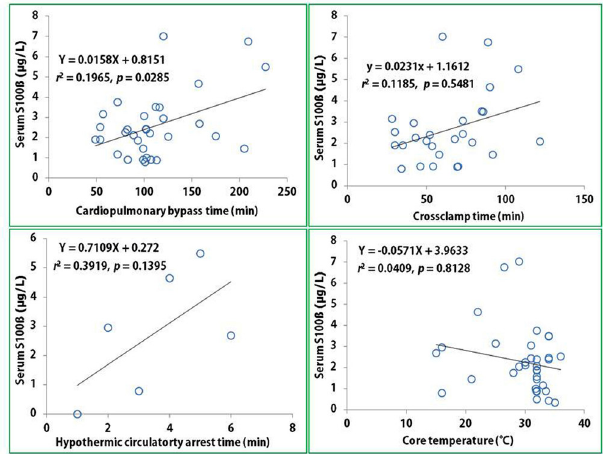
Fig. 8 - Linear correlation analysis showed serum S100ß concentration at T correlated closely with cardiopulmonary bypass 2